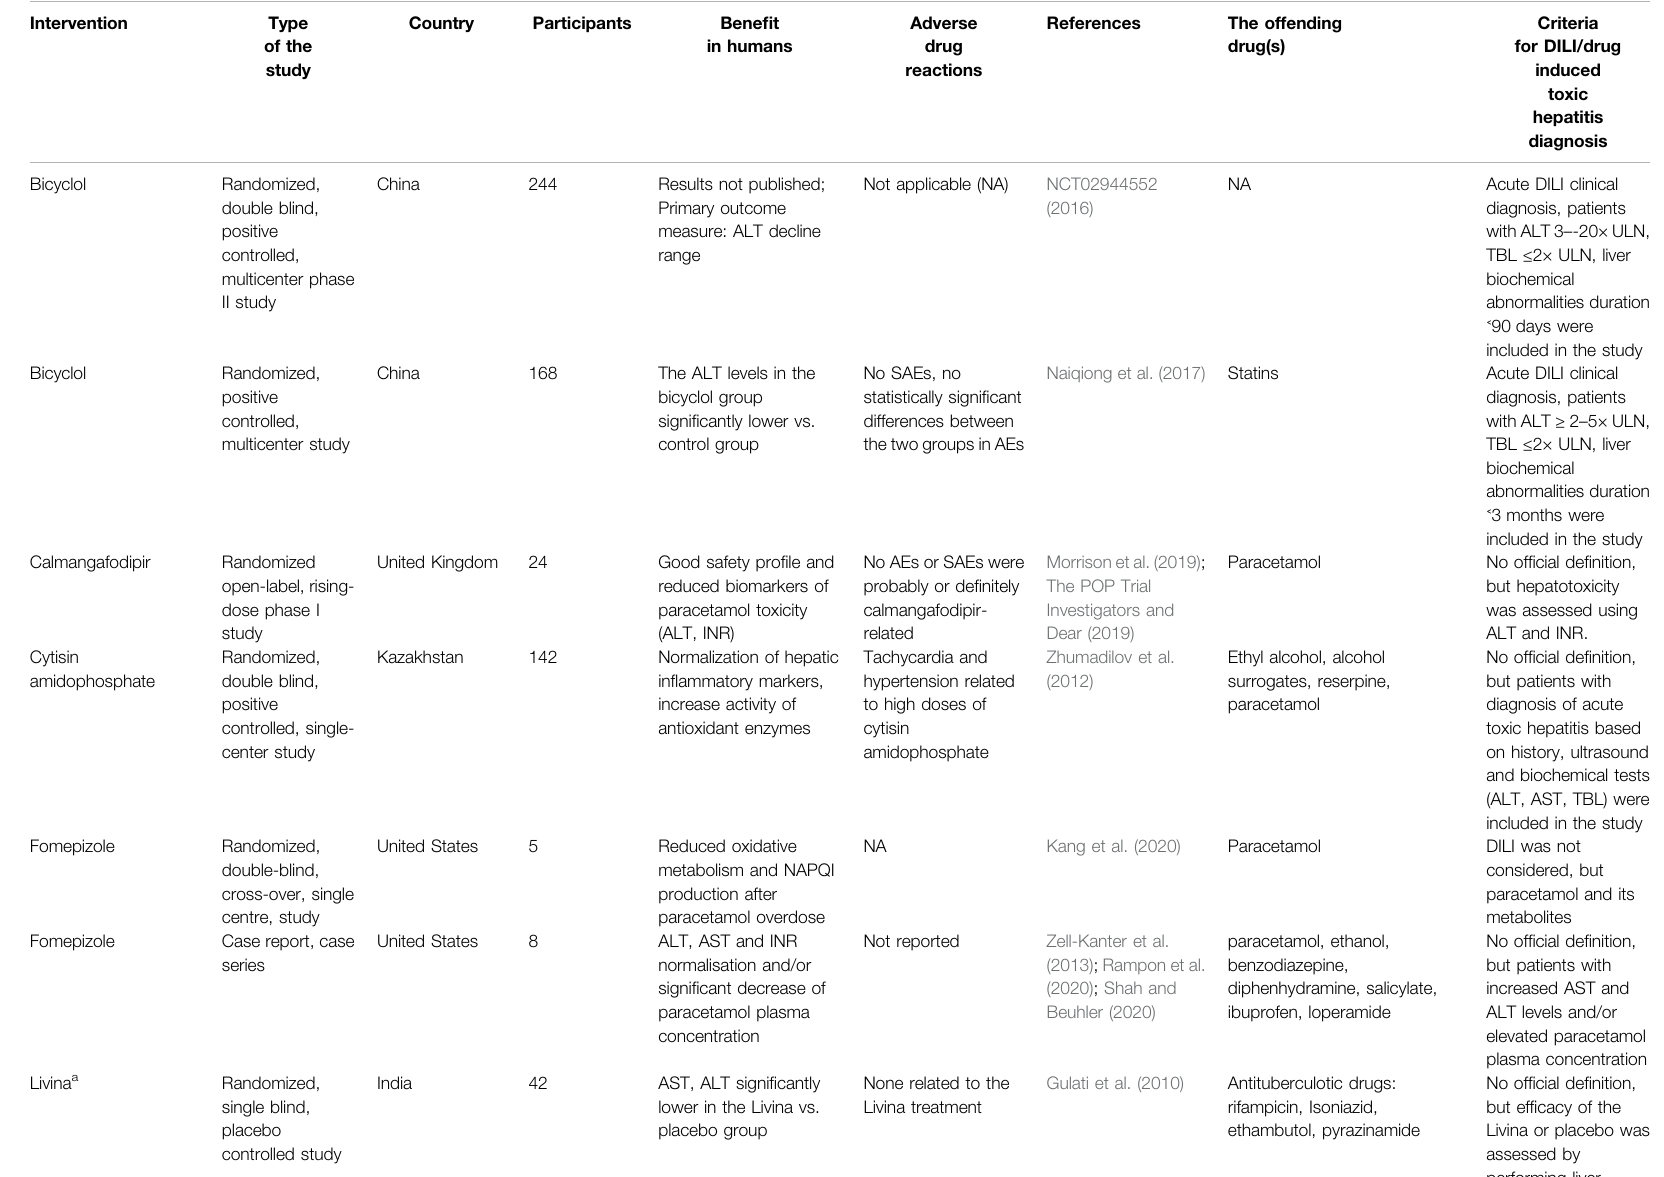
TABLE 2 | Characteristics of included